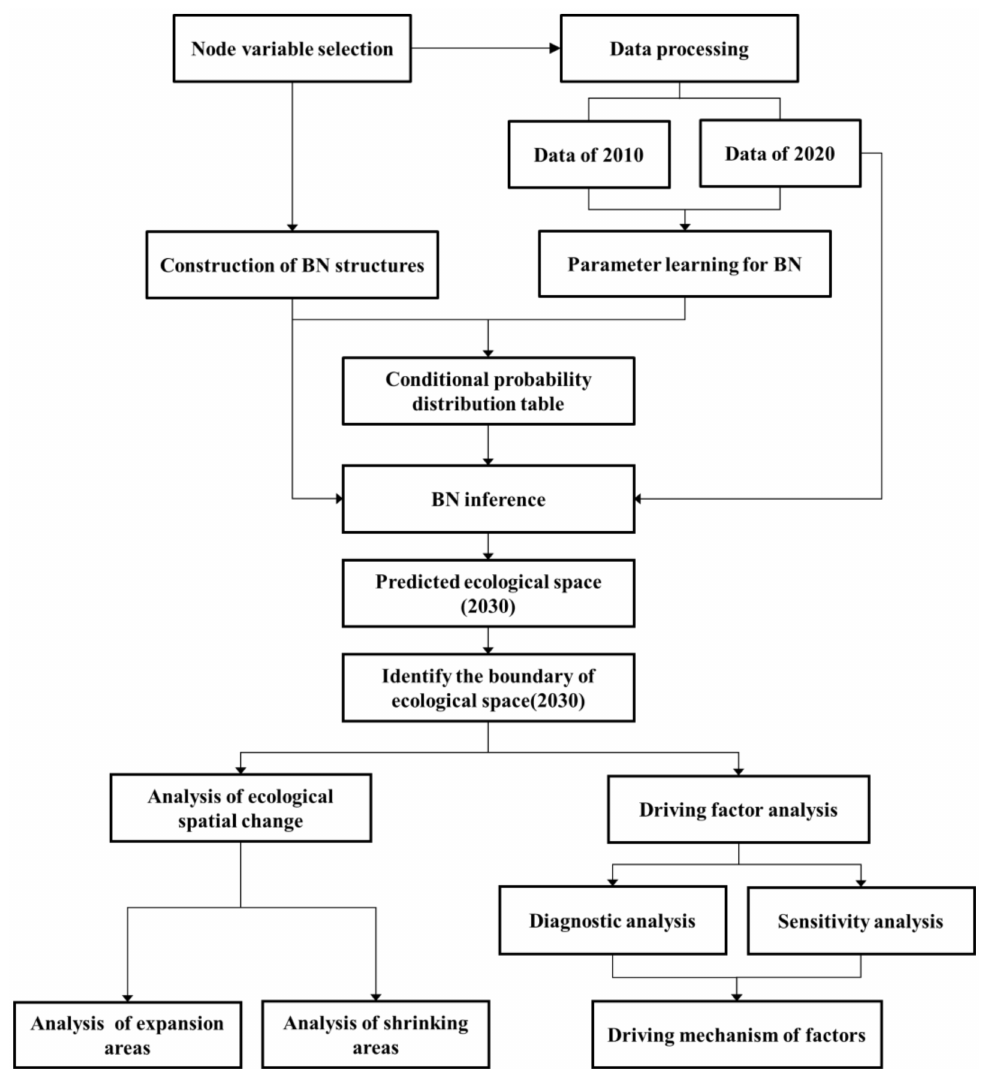
Figure 1. The flowchart of the